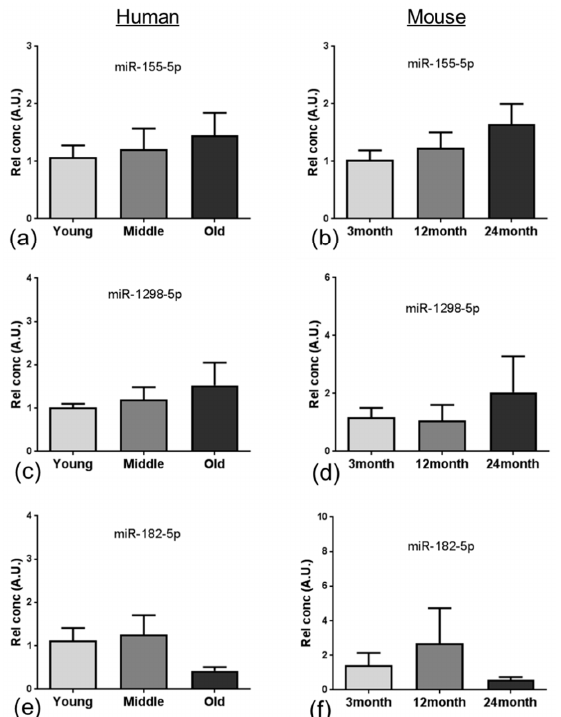
Figure 5. Investigation of protein expression by candidate genes identified in array analysis. ( a ) SLUG ( SNAI2 ) and ( b ) p53 ( TP53 ) immunolabelled a proportion of endothelial cell nuclei. ( c ) Immunoreactivity for RB1CC1 ( RB1CC1 ) was predominantly associated with the basement membrane of capillaries. ( d ) In addition to endothelial immunoreactivity, beclin-1 ( BECN1 ) cytoplasmic staining of pyramidal neurones (examples indicated by the open arrow) was present throughout the cortex (Figure 6d). Immunopositive staining of the BBB is indicated by the black arrow. Scale bar represents 50 μ m (a,b,c) or 100 μ m (d).